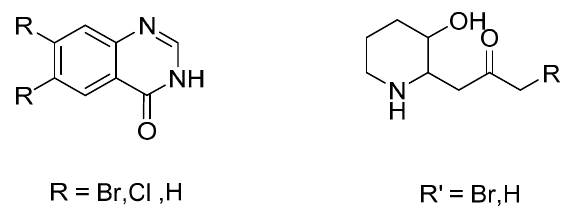
Figure 2. 4(3 H )-Quinazolinone ( L ) and piperidine ( R ) derivative.